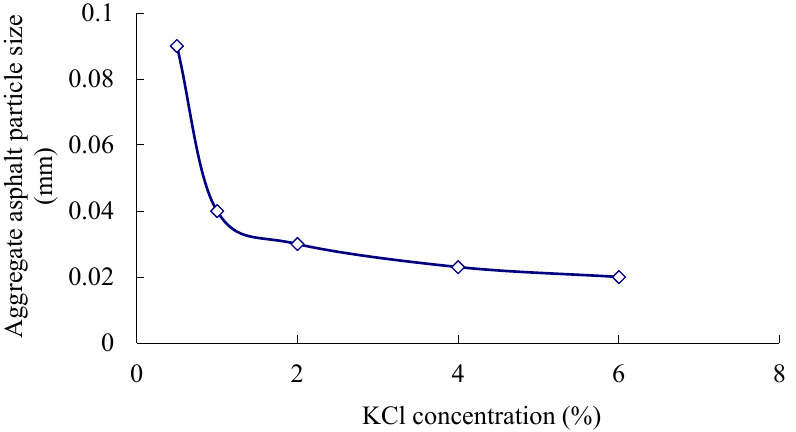
Figure 4. Size of asphalt binder after adding different concentrations of KCl.